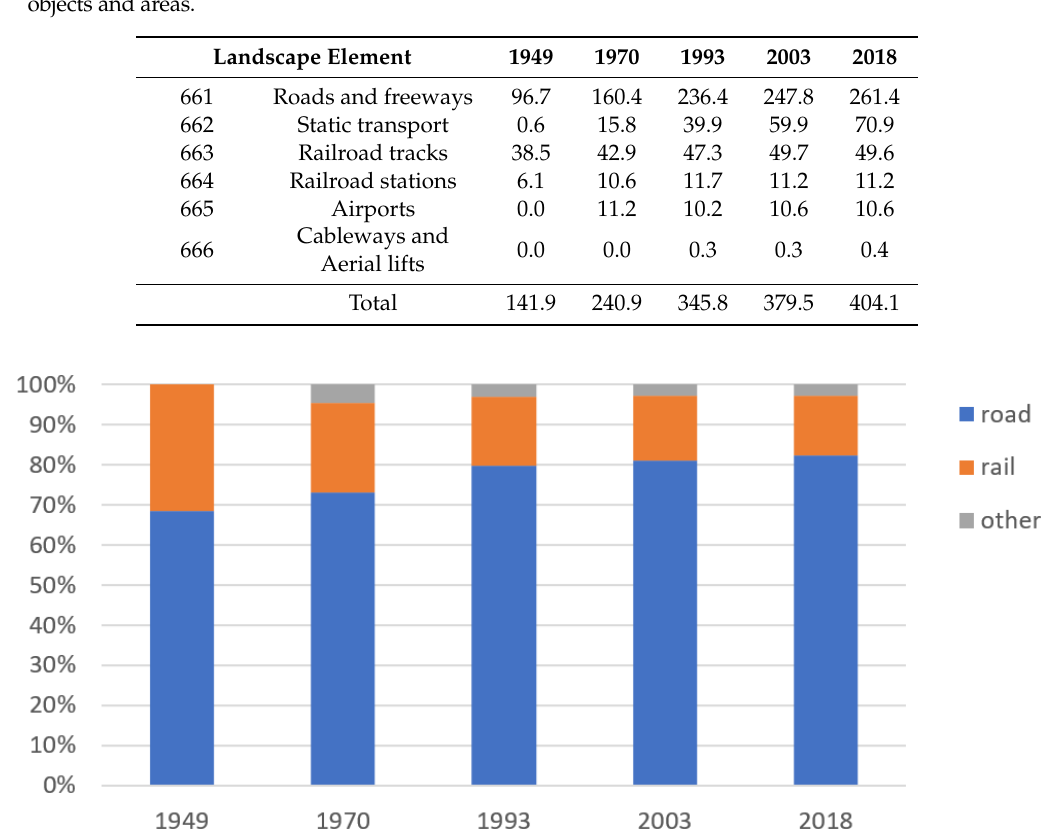
Table 4. Landscape change categories and their proportion rates in percent.